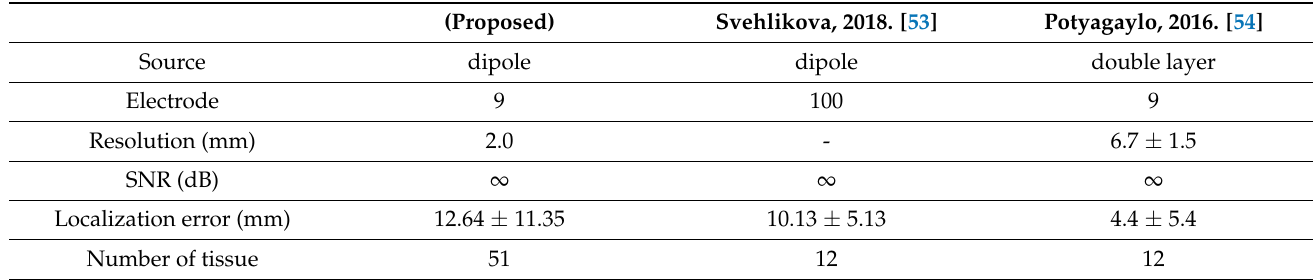
Table 6. Localization performance and specifications of the proposed method and related